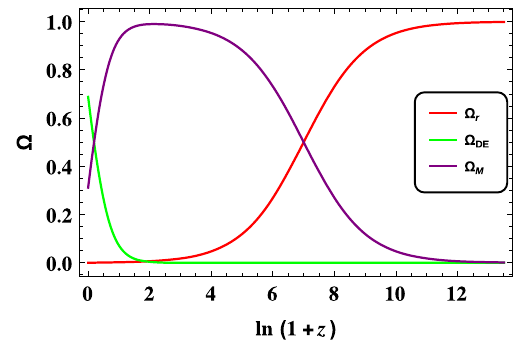
Fig. 2 Evolutions of dark energy equation of state parameter with red- shift for quintessence dark energy model with DM–DE interaction (red line) and in the absence of DM–DE interaction (green